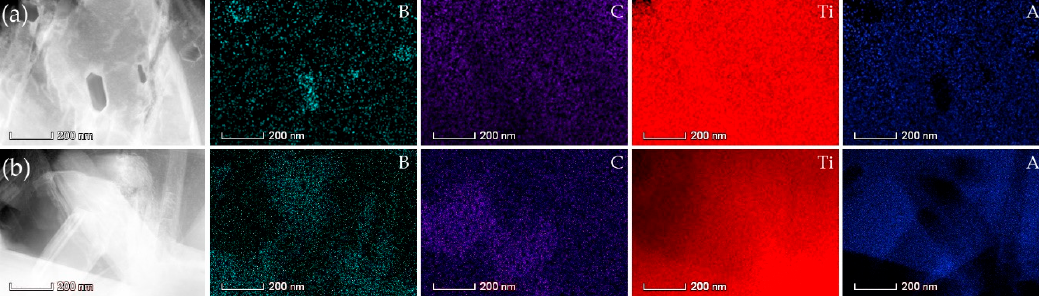
Figure 6. TEM images and compositional mappings: (a) Ti + 30 vol. % B 4 C + 20 vol. % Ti-Al(1) and (b) Ti + 30 vol. % B 4 C + 20 vol. % Ti-Al(2).